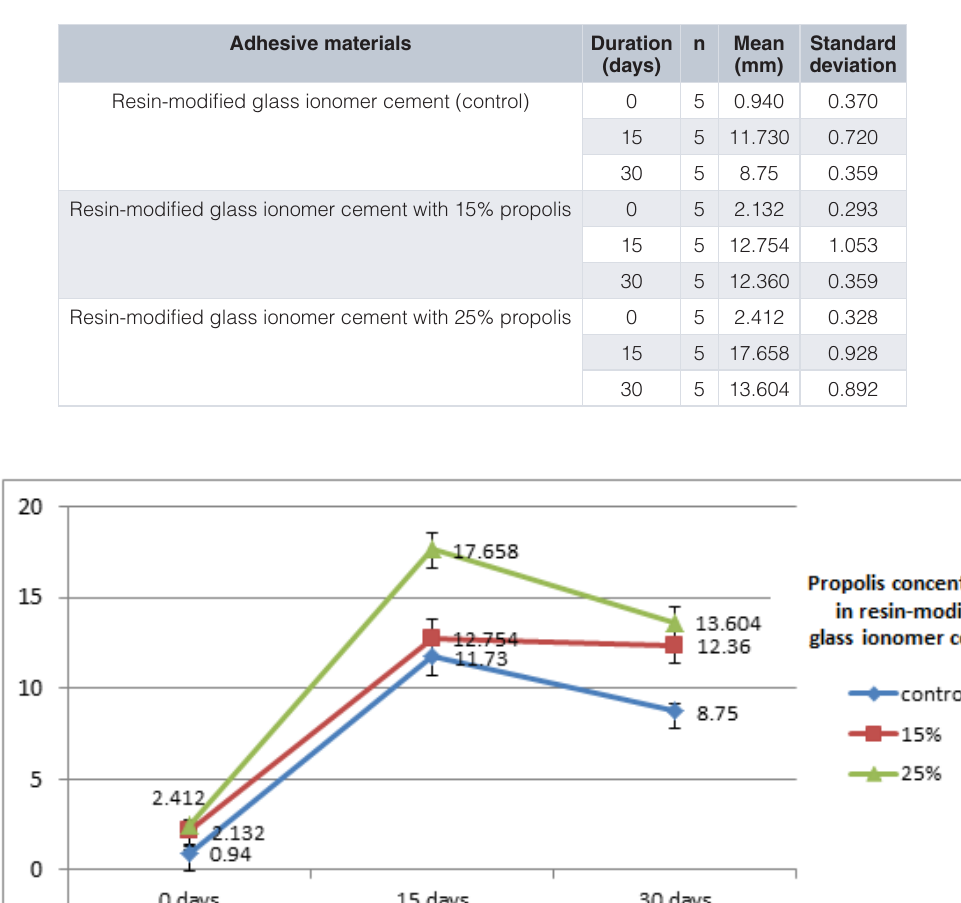
Table 1. Means and standard deviation of growth inhibition zone of Streptococcus mutans among groups. Percentages are propolis concentration in resin-modified glass ionomer cement.